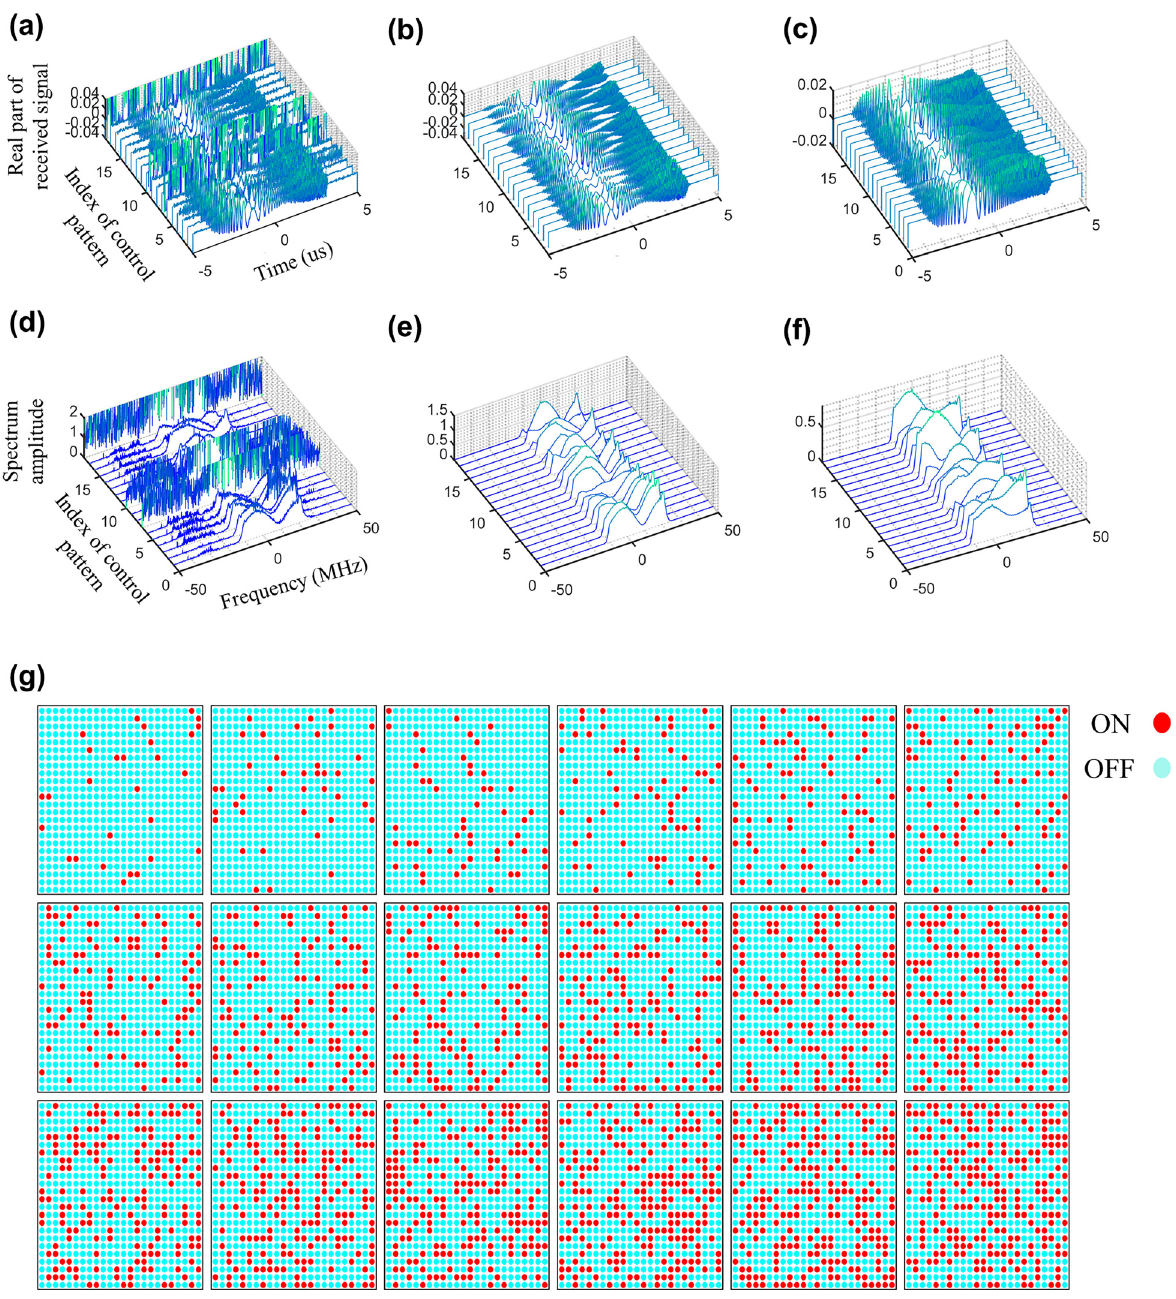
Figure2: Experimental results of the signal denoise for proposed intelligent EM metasurface camera working at around 2.4 GHz. This set of experiments are conducted in indoor environment as shown in Figure 1c. (a) Real parts of time-domain down-converted signals where 18 random control patterns of metasurface are considered. This figure clearly showsveryseriousin-bandandout-of-banddisturbances.(b)Realpartsof18denoisedtime-domainsignalsin(a)throughtheproposedFilter- CNN. (c) Real parts of mean-valued- fi ltered signals of 2b.(d) – (f) are the spectrumamplitudes corresponding to those in (a) – (c). (g)18 random control patterns of the metasurface used in this set of